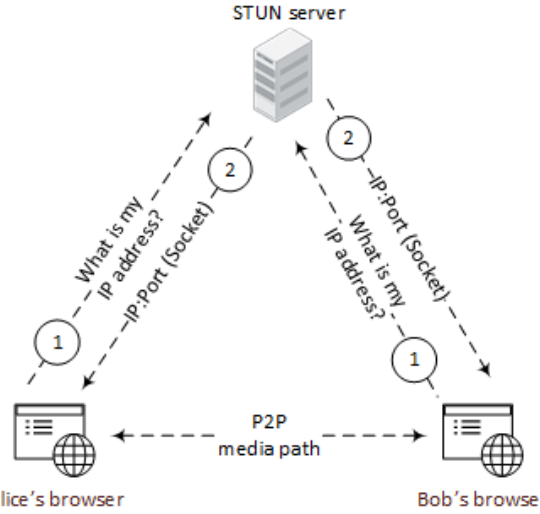
Figure 3. Using a STUN